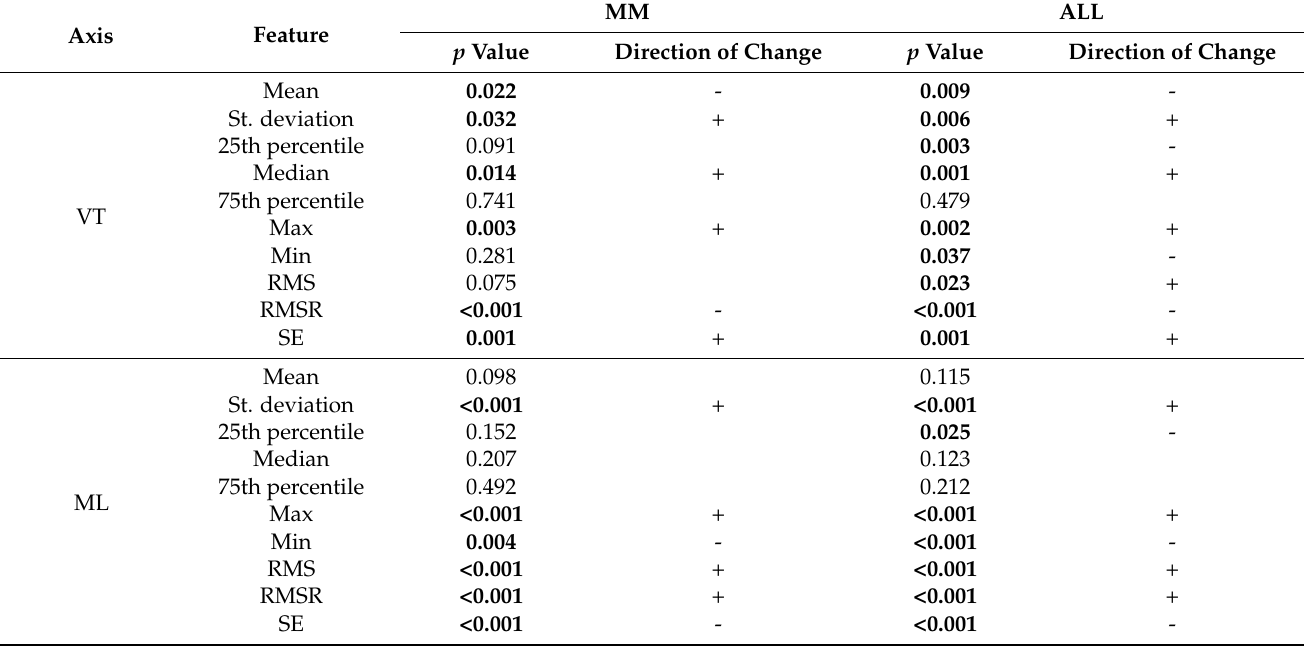
Table 2. Main effects for fatigue state in each axis of the acceleration signal. Direction of change indicates differences from NF to FT. Significant p -values in bold. VT = vertical, ML = mediolateral, AP = anterior–posterior, RES = resultant; MM = comparison performed between MLSS1 and MLSS2, ALL = comparison performed between all four trials. RMS = root mean square, RMSR = ratio of root mean square, SE = sample